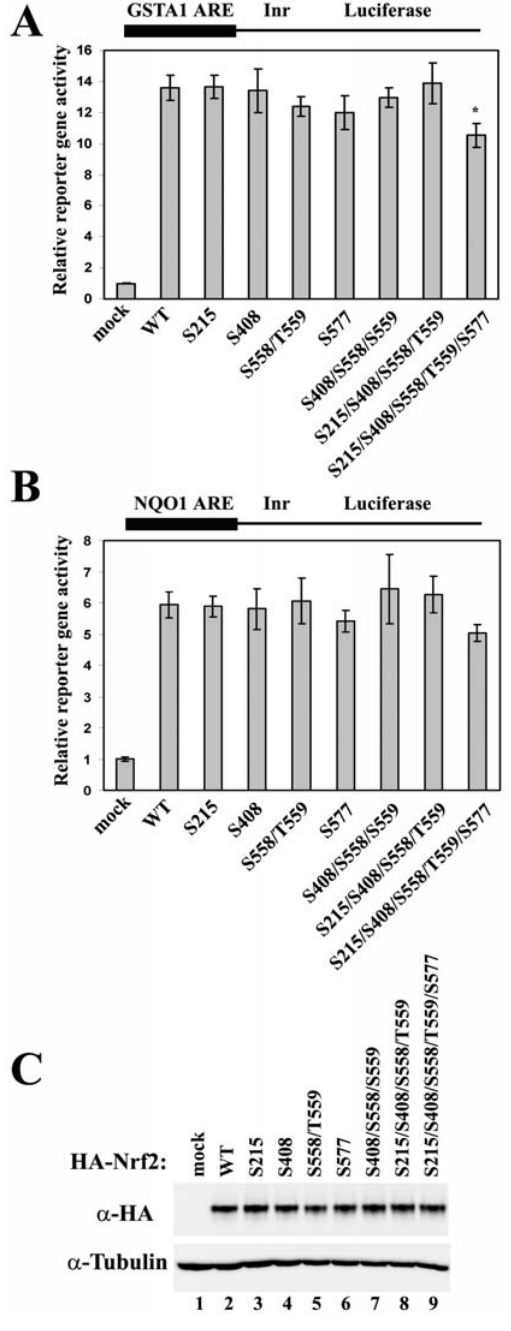
Figure 2. Combined alanine substitution on all phosphoryla- tion sites causes only a moderate decrease in the transcrip- tional activity of Nrf2. (A) MDA-MB-231 cells were cotransfected with expression vectors for the GSTA1-ARE-dependent firefly luciferase, the TK-Renilla luciferase, and the indicated Nrf2 mutant. Luciferase reporter gene activities were analyzed using the Promega dual- luciferase reporter gene assay system. WT: wild-type; TK: thymidine kinase promoter; Inr: initiator. Relative luciferase activities and standard deviations were calculated from three independent assays. * p , 0.05 when compared to WT. (B) Reporter gene assay was performed as described above using NQO1-ARE-dependent luciferase reporter gene construct in MDA-MB-231 cells. (C) Total cell lysates from one of the reporter gene assays were subjected to immunoblot analysis with anti- HA antibodies for detection of